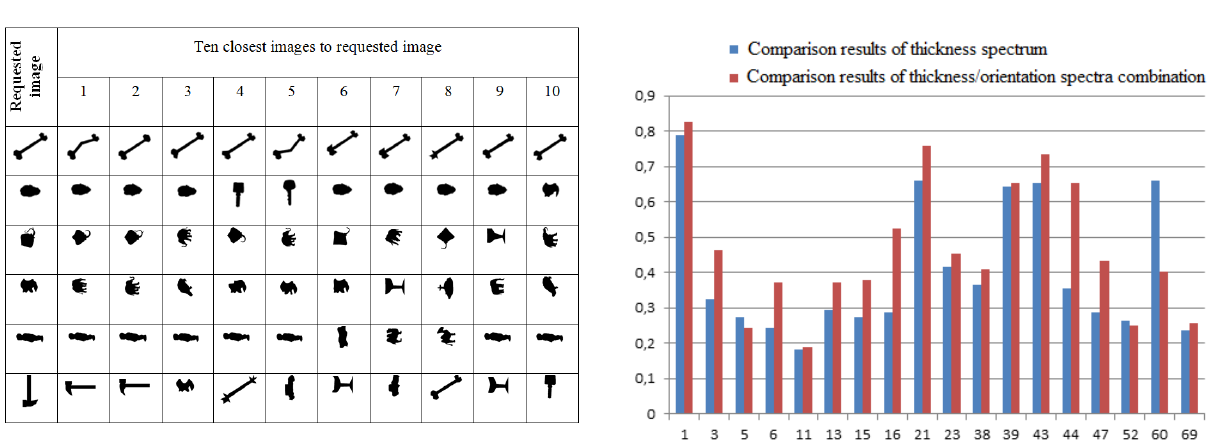
Figure 14: Average precision for thickness spectra and thick- ness/orientation